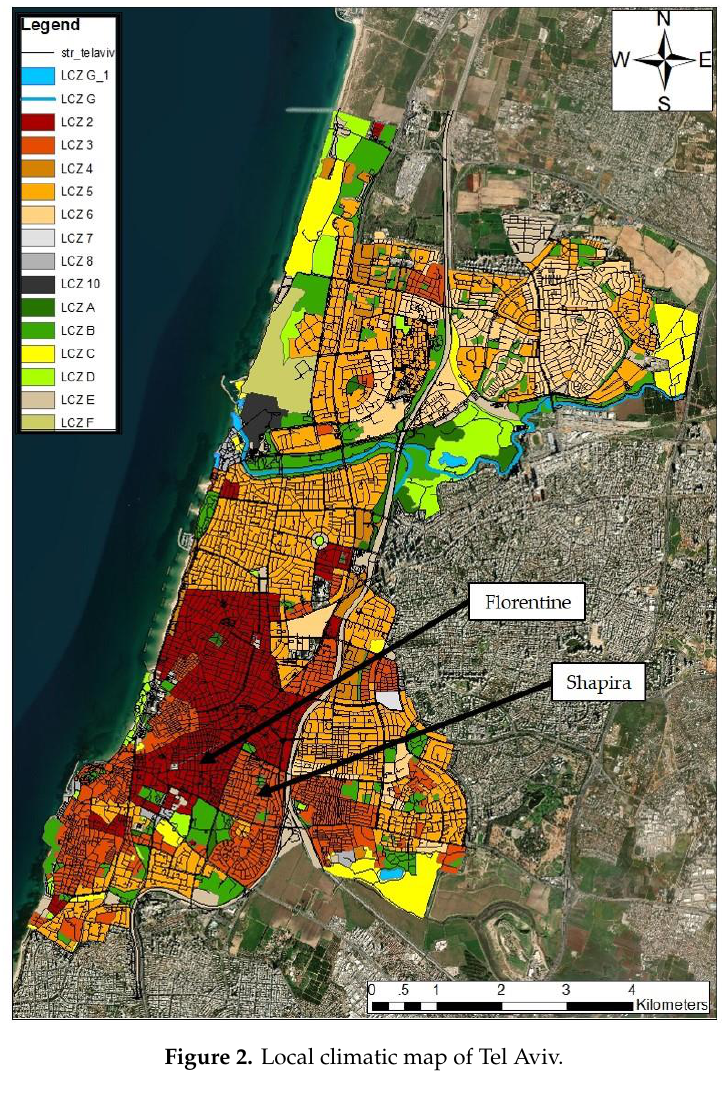
Figure 2. Local climatic map of Tel Aviv.